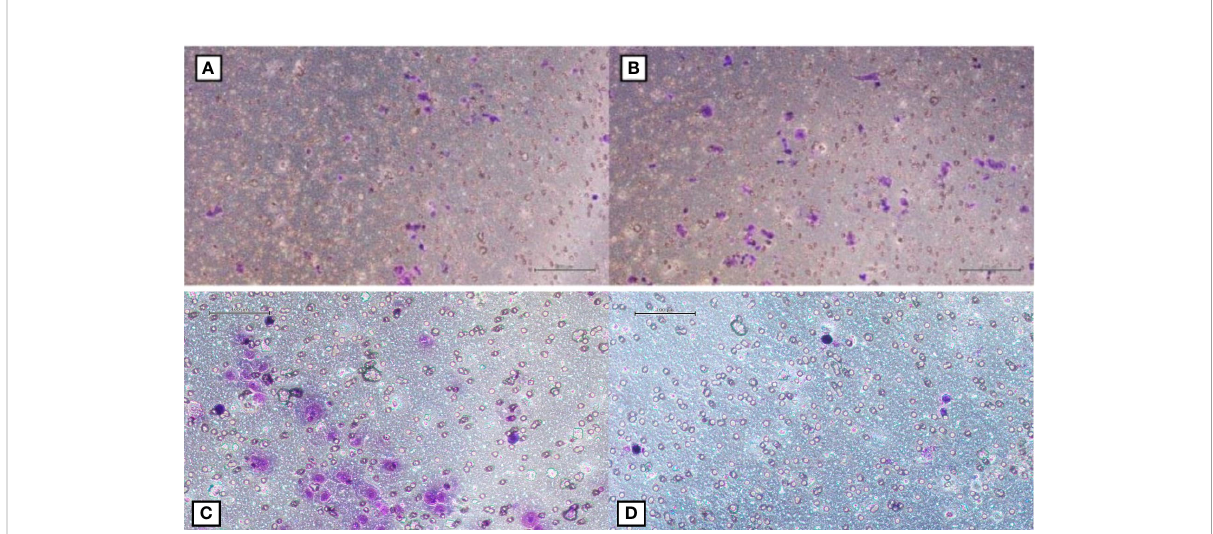
FIGURE 1 (A, B) Migrated AsPC-1 cells after the exposure of fi broblasts to 1 Gy and 2 Gy of photons respectively; (C, D) Migrated AsPC-1 cells after the exposure of fi broblasts to 1 Gy and 2 Gy of C-ions respectively.